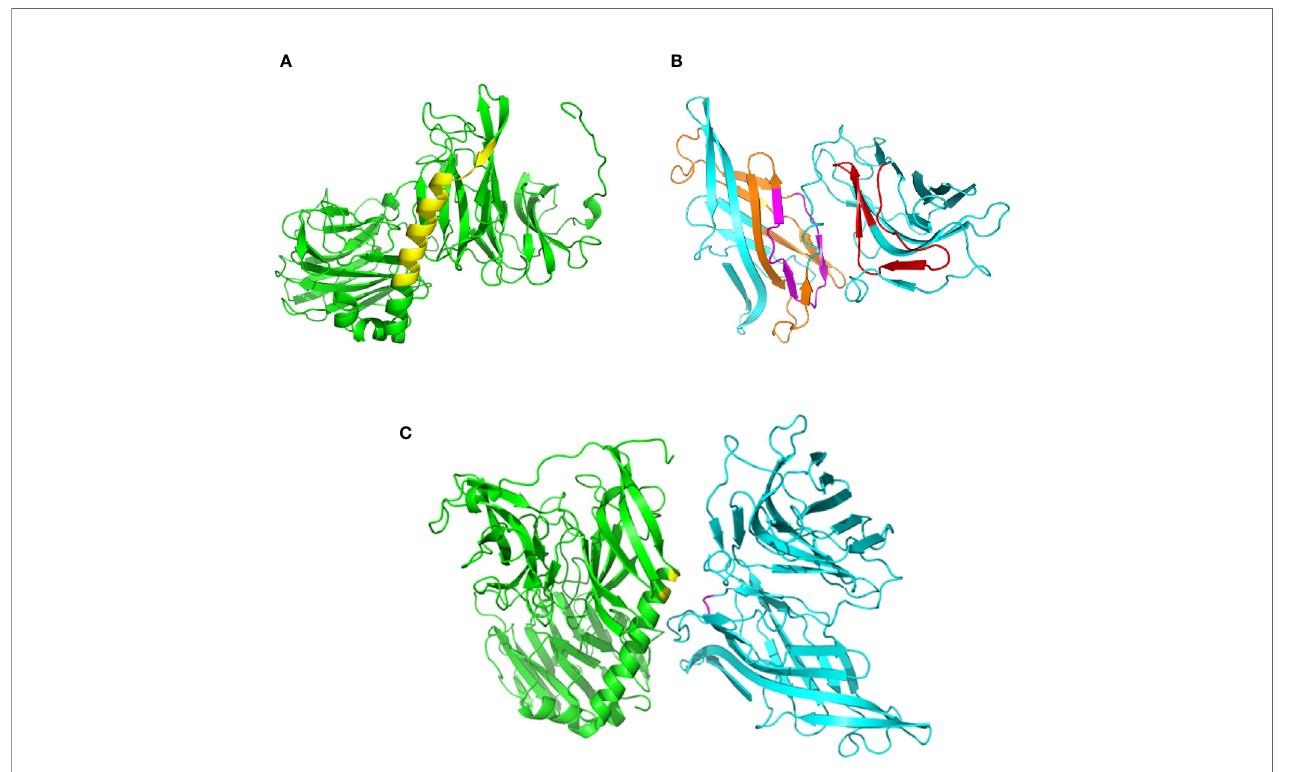
FIGURE 1 | Structural models of gp82 and LAMP2 proteins and their presumed interaction. (A) T. cruzi surface molecule gp82, without residues 1 – 29 (N-terminus) and 500- 516 (C-terminus). The cell binding site is highlighted (yellow). (B) LAMP2 without residues 1 – 29 (N-terminus) and 378 – 410 (C-terminus). Domains that potentially interact with gp82 are indicated (orange and red). Also indicated is the presumed site of interaction with gp82 cell binding site (magenta). (C) Highlighted in the model of gp82 – LAMP2 interaction are the gp82 residues E259 and K262 (yellow) and the presumed LAMP2 amino acid residues involved in the interaction